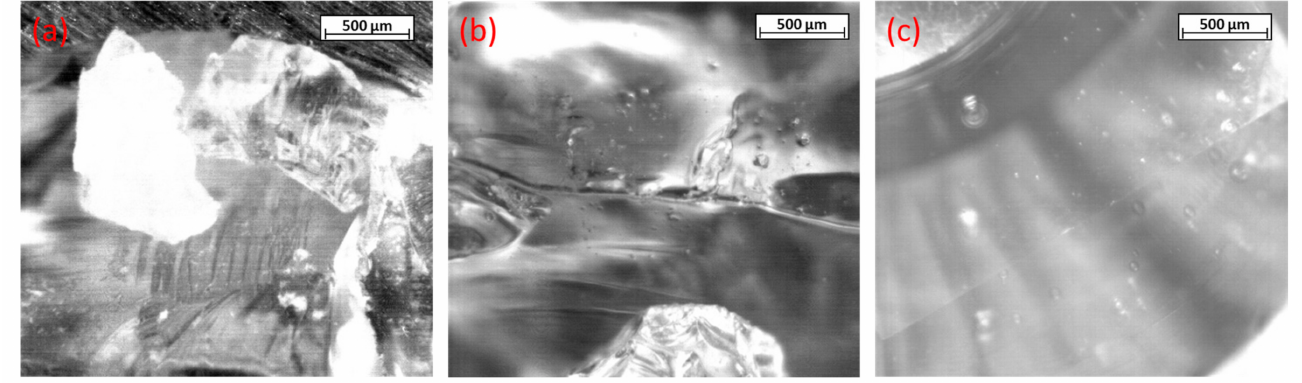
Figure 4. ( a ) Glassy slag chunks; ( b ) melting of slag; ( c ) liquid slag over steel